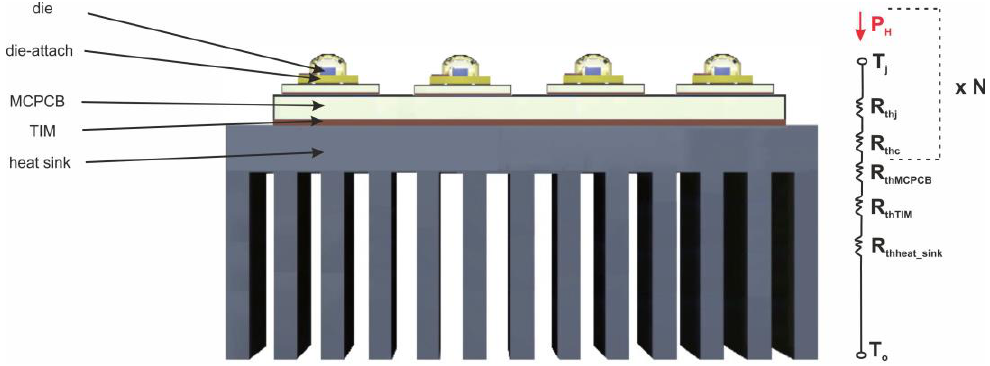
Figure 1. Components of the thermal resistance of the led panel.